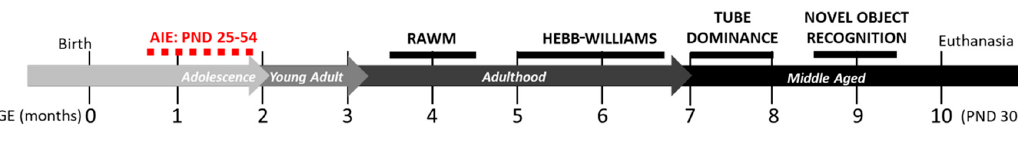
Figure 1. Experimental timeline of adolescent intermittent ethanol (AIE) and behavior tests across the lifespan. Long Evans rats underwent intermittent gavage with either water (CON) or 5 g / kg ethanol (AIE) across adolescence (postnatal day (PND) 25–54). After two months of rest, rats began a battery of behavioral tests that included spatial (radial arm water maze, Hebb-Williams maze) and non-spatial (novel object recognition) memory tasks as well as an assessment of dominance behaviors (tube dominance test). In every test, females and males were tested separately. Rats were allowed at least two weeks of recuperation between each test. There were 14 CON rats ( n = 8 male, n = 6 female) and 13 AIE rats ( n = 7 male, n = 6 female).